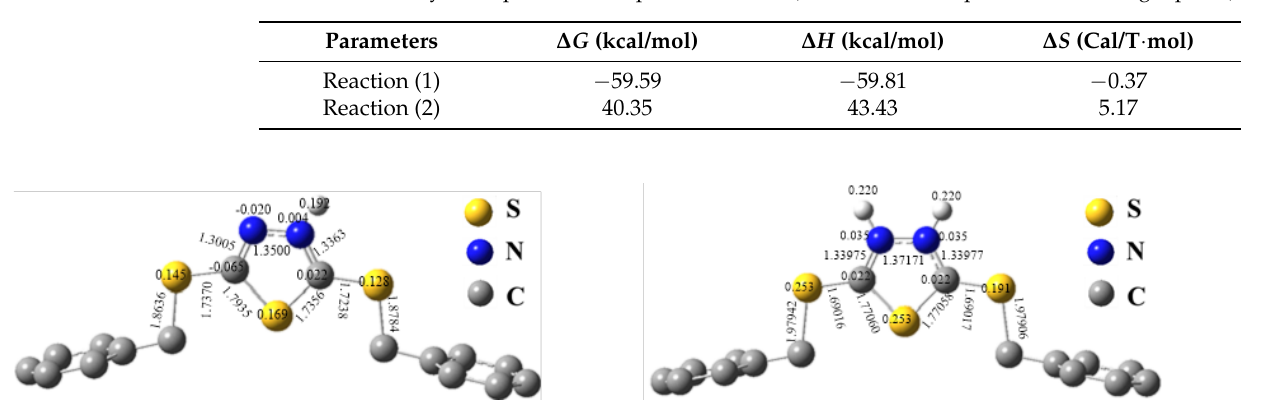
Figure 8. The optimized structure and Mulliken atomic charge of the model molecule L (at B3LYP/6- 31G**/SDD level).